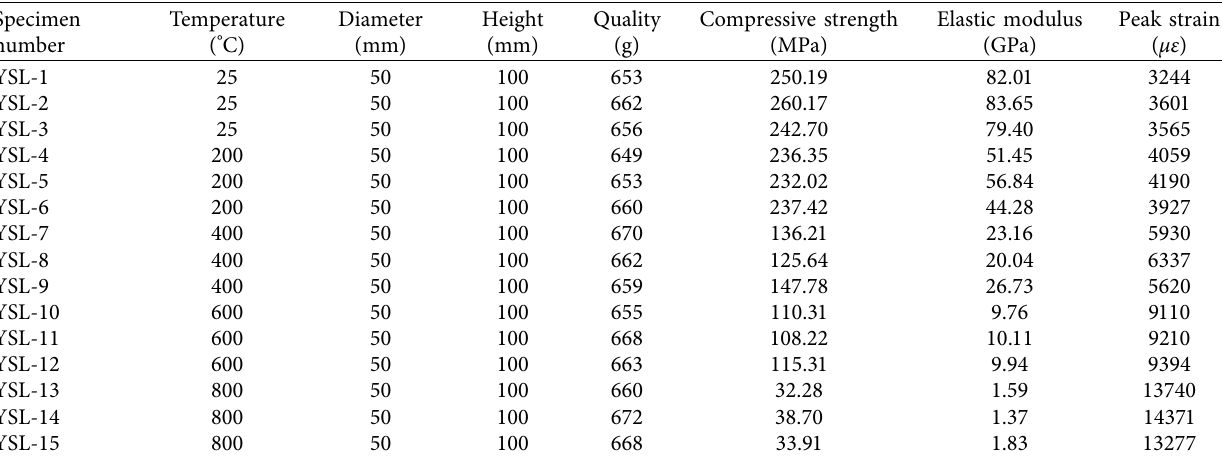
Table 2: Uniaxial compression test data (water cooling).